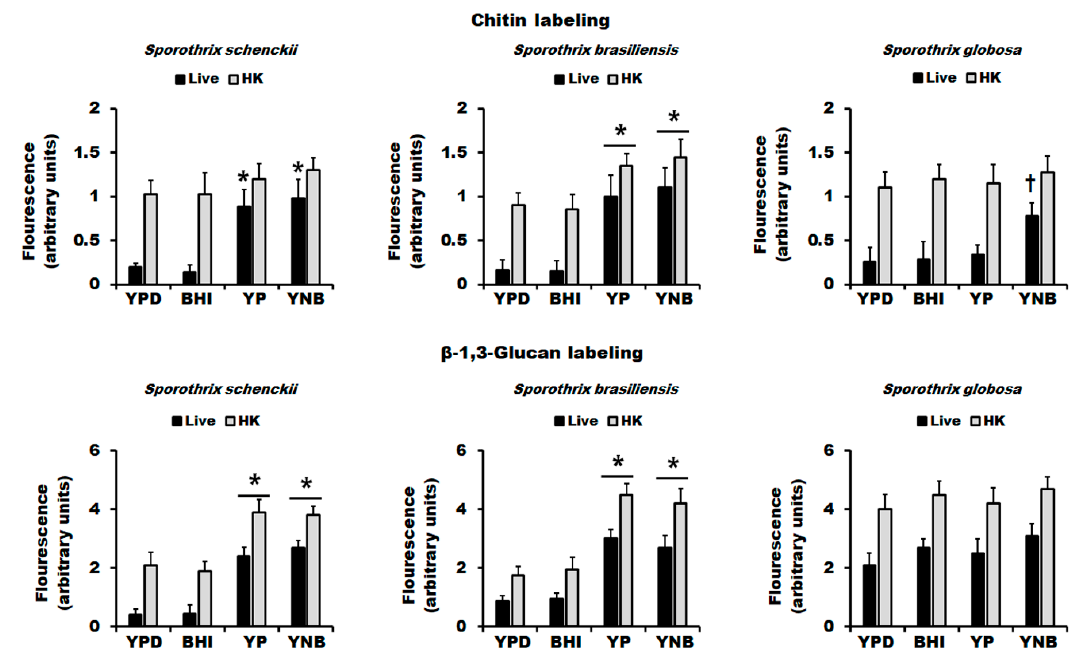
Figure 5. Cell wall chitin and β -1,3-glucan labeling in Sporothrix schenckii , Sporothrix brasiliensis , and Sporothrix globosa growing in di ff erent culture media. Yeast-like cells grown in the indicated culturing media were harvested, washed, and labeled with either fluorescein isothiocyanate–wheat germ agglutinin conjugate or IgG Fc-Dectin-1 chimera for chitin and β -1,3-glucan, respectively, and inspected under fluorescence microscopy, and the fluorescence of 300 cells per condition was calculated as described in the Materials and Methods section. Data are represented as mean ± standard deviation of the three independent experiments performed in duplicate. * p < 0.05 when compared to the fluorescence associated with YPD- or BHI-grown cells under the same condition. † p < 0.05 when compared to live cells grown in YPD, BHI, or YP medium. HK, heat-killed cells.